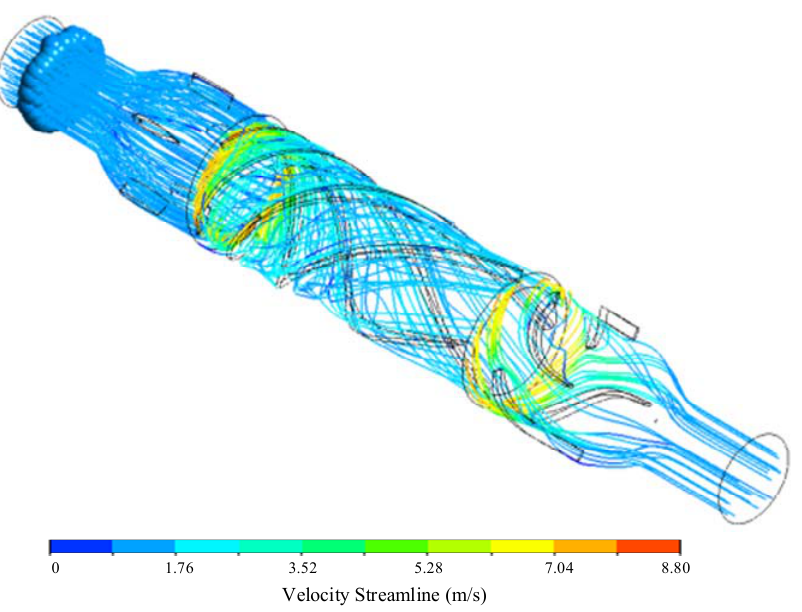
Figure 6. Particles of blood when released.